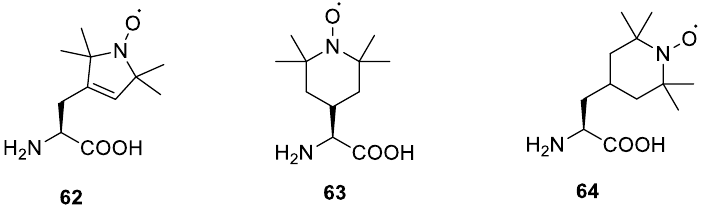
Figure 3. Structure of three spin-labeled target amino acids ( 62 – 64 ).